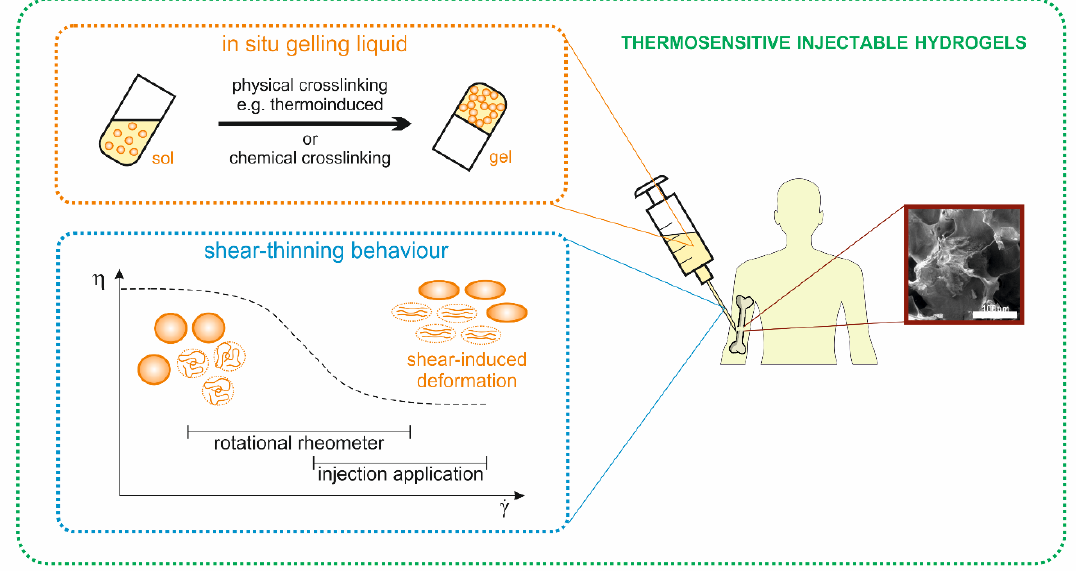
Figure 1. Graphical interpretation of the synergistic properties of thermosensitive injectable hydrogels.